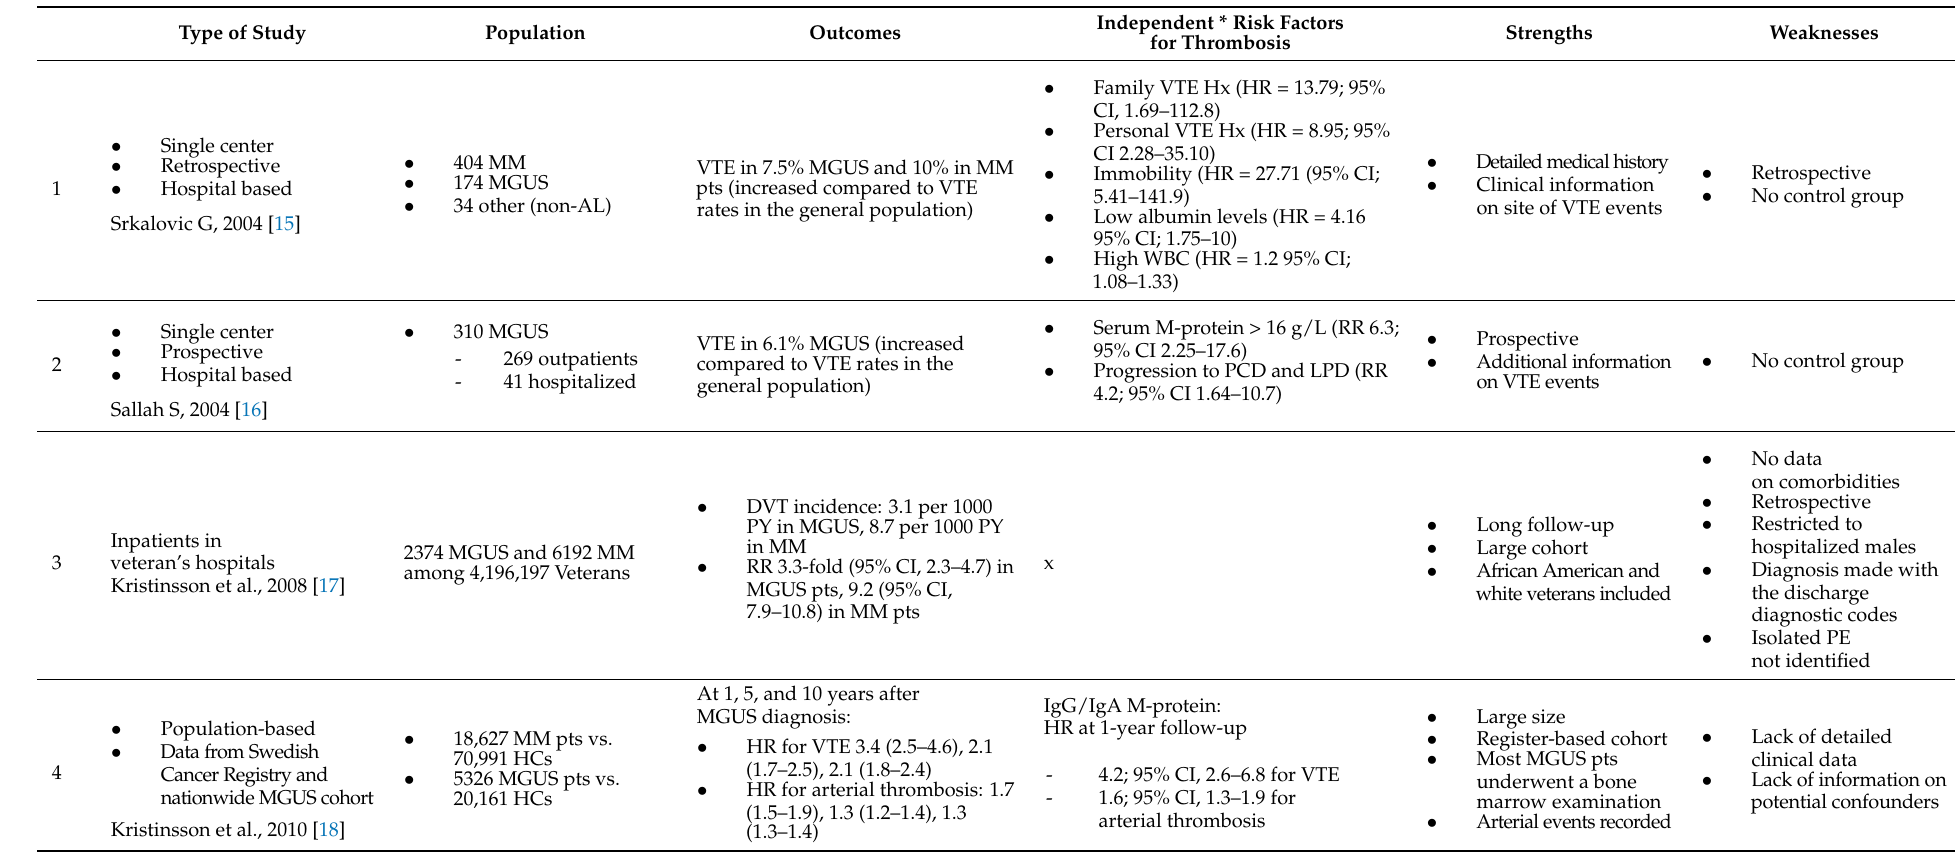
Table 1. Main population-based peer-reviewed studies reporting the incidence of venous thromboembolism and associated independent risk factors confirmed in multivariate analysis) in patients with Monoclonal gammopathy of undetermined significance (MGUS). MM: multiple myeloma, PCD: plasma cell dyscrasias, LPD: lymphoproliferative disorder, HC: healthy controls, AL: AL amyloidosis, pts: patients, VTE: venous thromboembolism, DVT: deep venous thromboembolism, X: not reported, CVD: cardiovascular disease, M-protein: monoclonal protein, HR: hazard ratio, WBC: white blood cells. IRR: Incidence rate ratio, PY: person-years, * Confirmed by multivariate